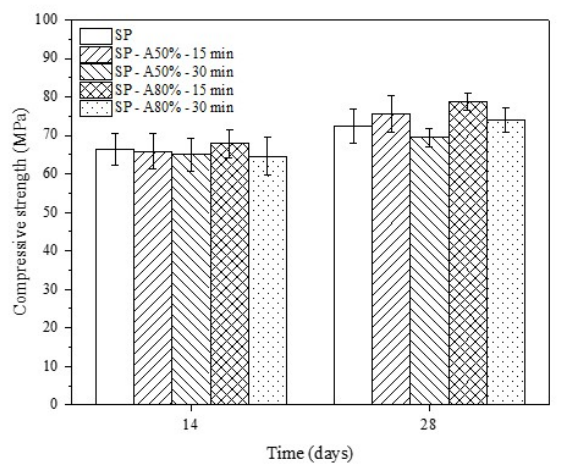
Figure 10. Compressive strength of the